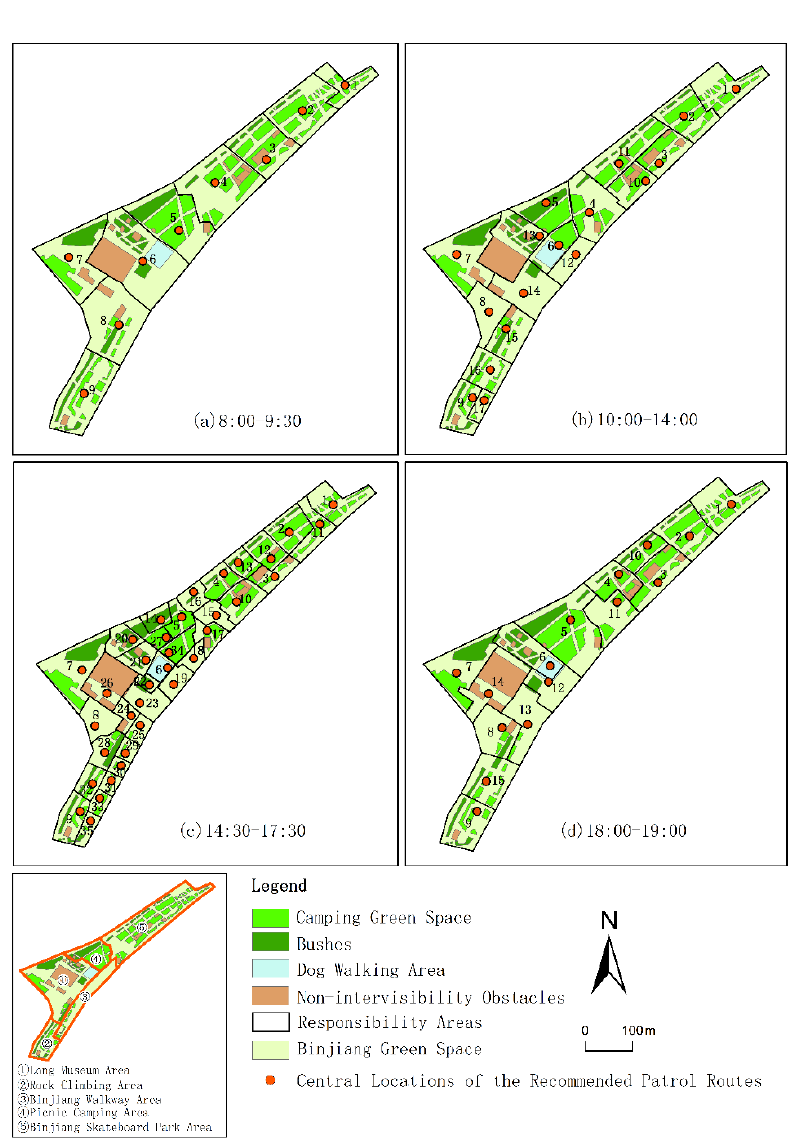
Figure 15. Zoning of evacuation guiders’ responsibility areas in different time periods.